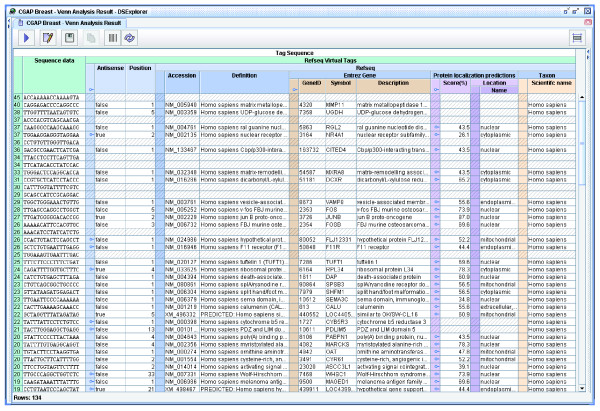
A detail from the main table of the DiscoverySpace Explorer showing the ability to draw together multiple annotations. The user has taken the resulting tags from the Venn analysis and is viewing them in the DiscoverySpace Explorer. The user has mapped the tags to their human Refseq genes, via virtual tags. The user is also viewing various qualities of those Refseq genes, their Entrez gene counterparts and predicted subcellular locations (generated using PSORT [36]). Hatched cells indicate the absence of a mapping.